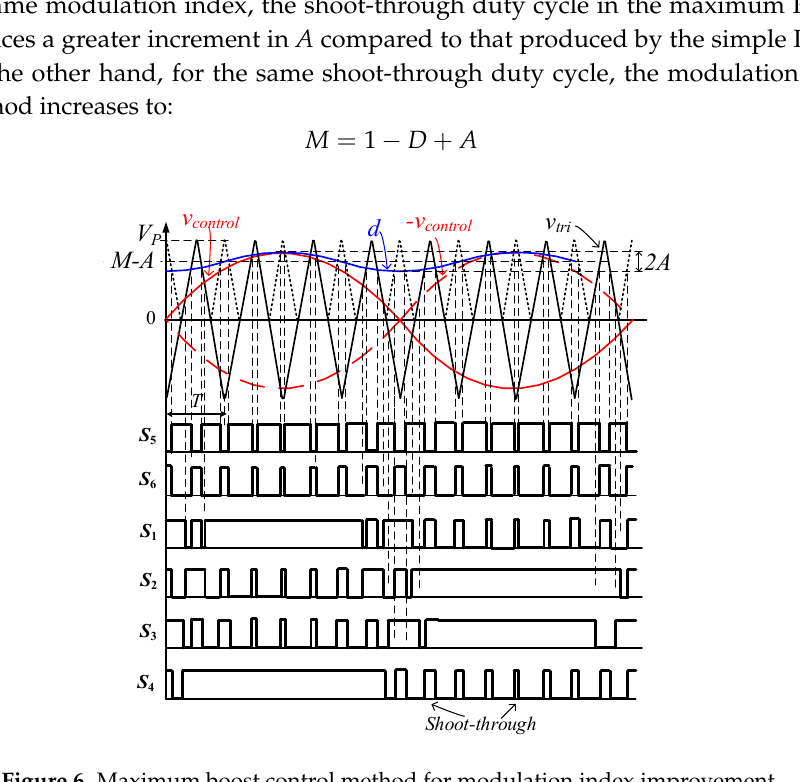
Figure 6. Maximum boost control method for modulation index improvement.